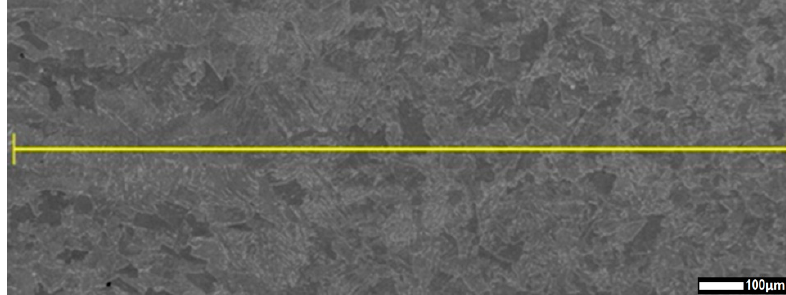
Figure 16. HAZ-to-FZ measurement line for chemical composition analysis.